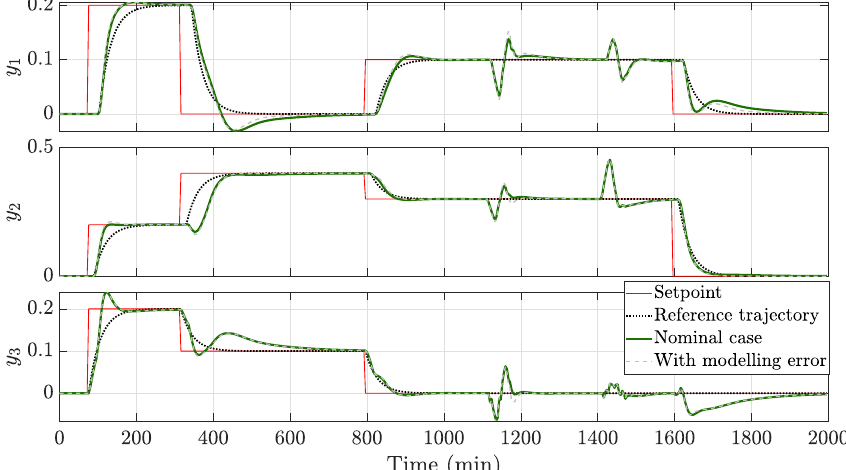
Figure 11. Case 2—Response of the HOF outputs to setpoint changes and disturbance rejections.